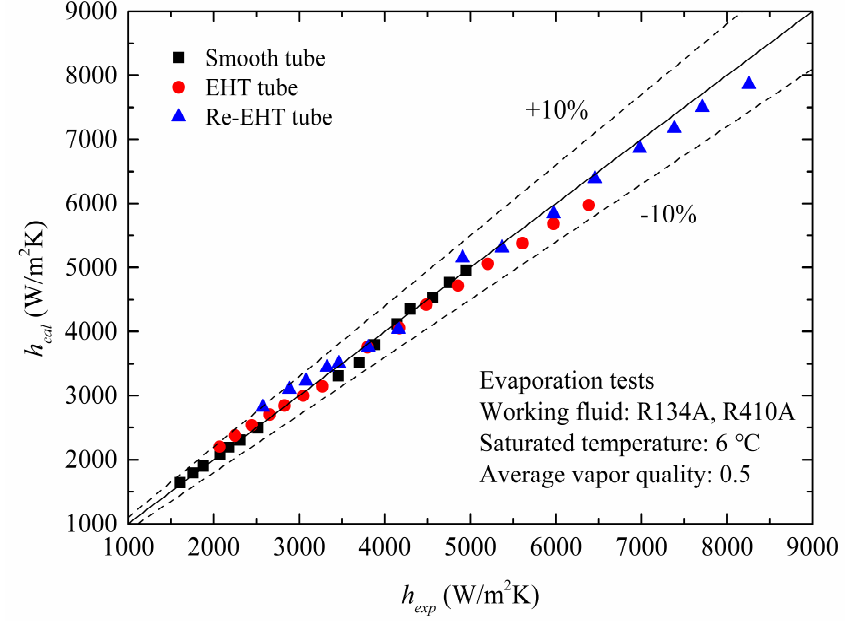
Figure 10. Evaluation of the modified correlation for the boiling heat transfer coefficient of the tested